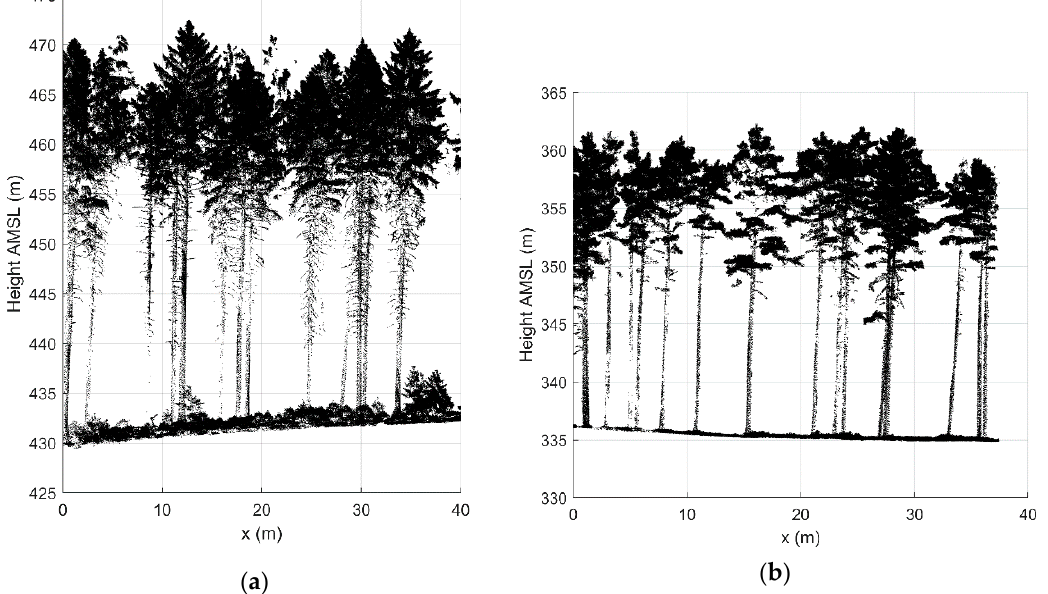
Figure 2. Structure of research forest stands: ( a ) a spruce stand (plot 1); ( b ) a pine stand (plot 5). Images show LiDAR representation of a transect 40 m long and 10 m